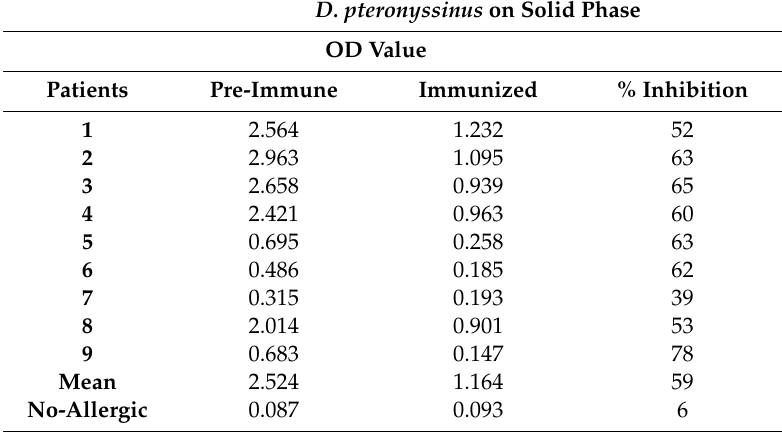
Table 1. Inhibition of patient’s IgE binding to D. pteronyssinus by mouse IgG antibodies induced by immunization with DPx4.